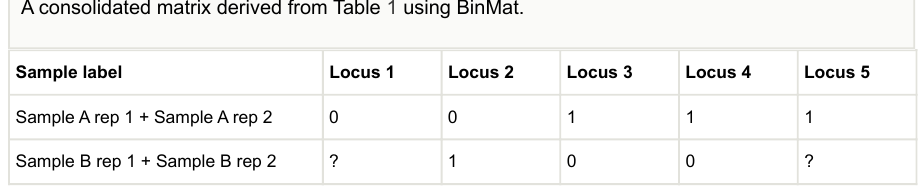
A consolidated matrix derived from Table 1 using